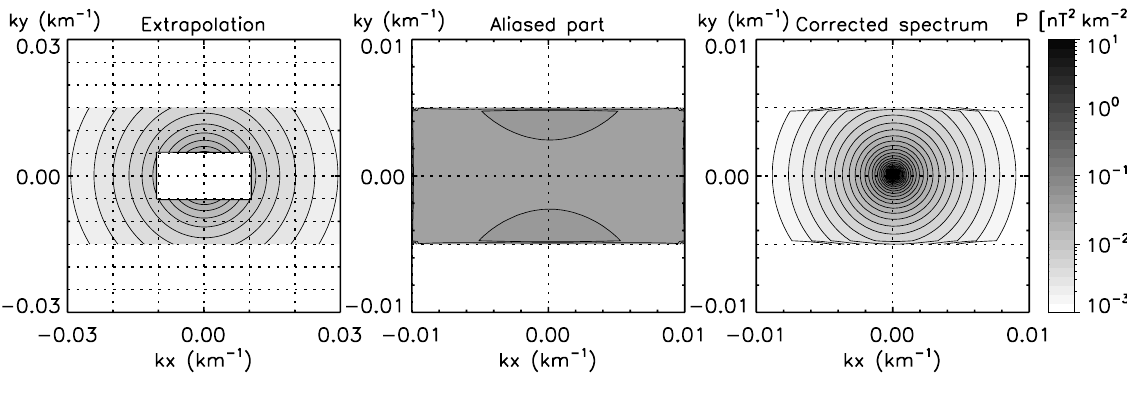
Fig. 12. Reconstruction of the spectrum by correcting the aliases. The spectrum is extrapolated for the neighboring cells in the wave vector domain (left panel), and then the alias of the extrapolated parts are estimated in the Brillouin zone (middle panel). The corrected or reconstructed spectrum is displayed in the right